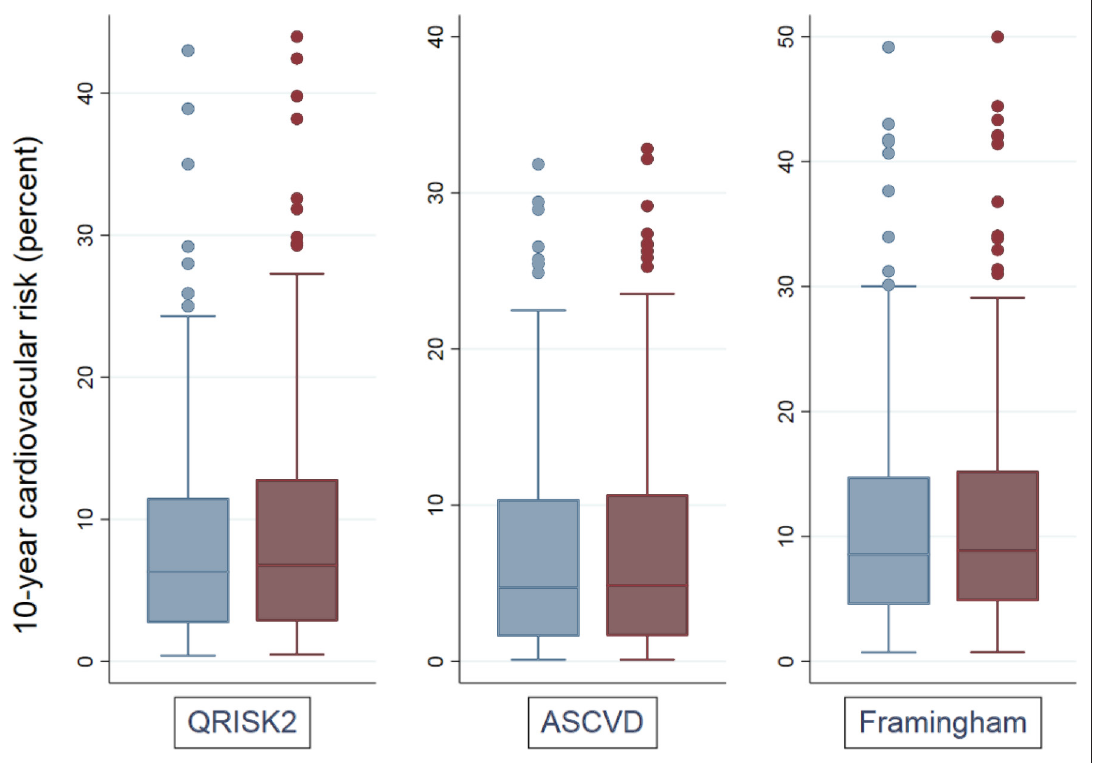
Figure 3 10- year cardiovascular risk scores before (blue, lighter colour) and after (red, darker colour) adjustment for systolic inter- arm